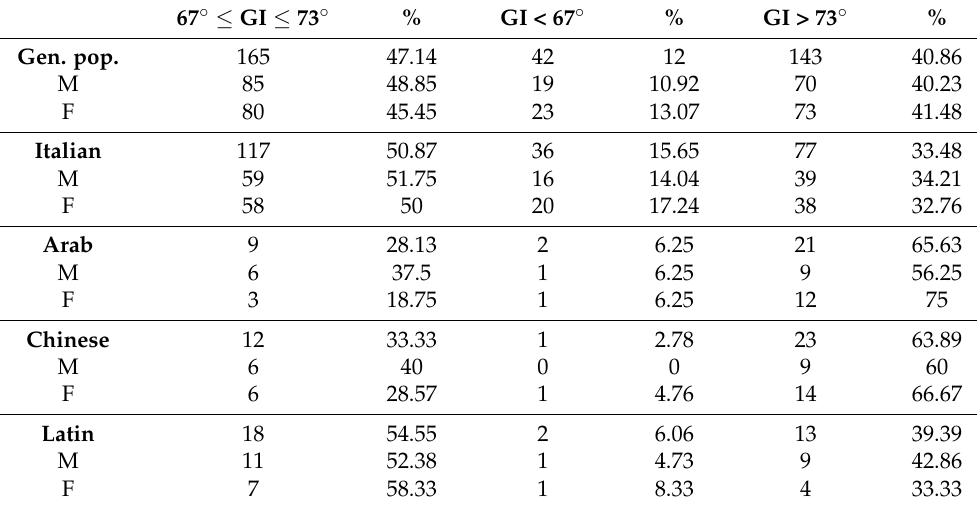
Table 13. Distribution of the lower gonial angle values in the selected patient sample. 67 ◦ ≤ GI ≤ 73 ◦ % GI < 67 ◦ % GI > 73 ◦ % Gen. pop.